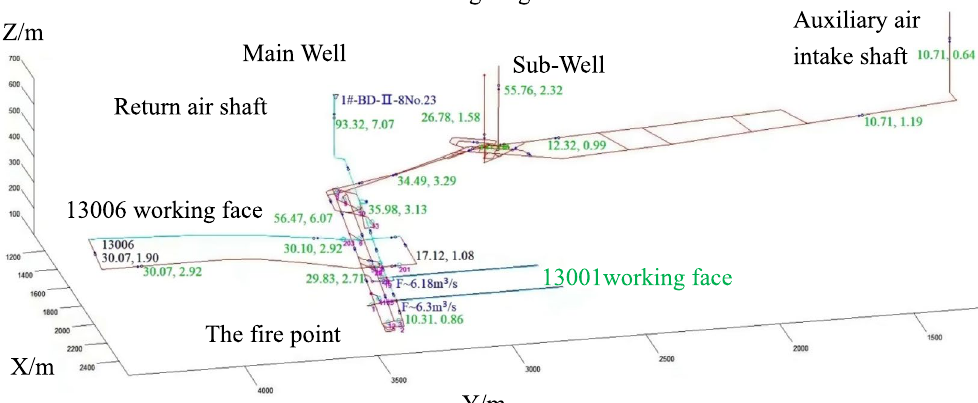
Figure 3. Three-dimensional wind volume annotation diagram of the TF1M3D simulation platform of Dayan